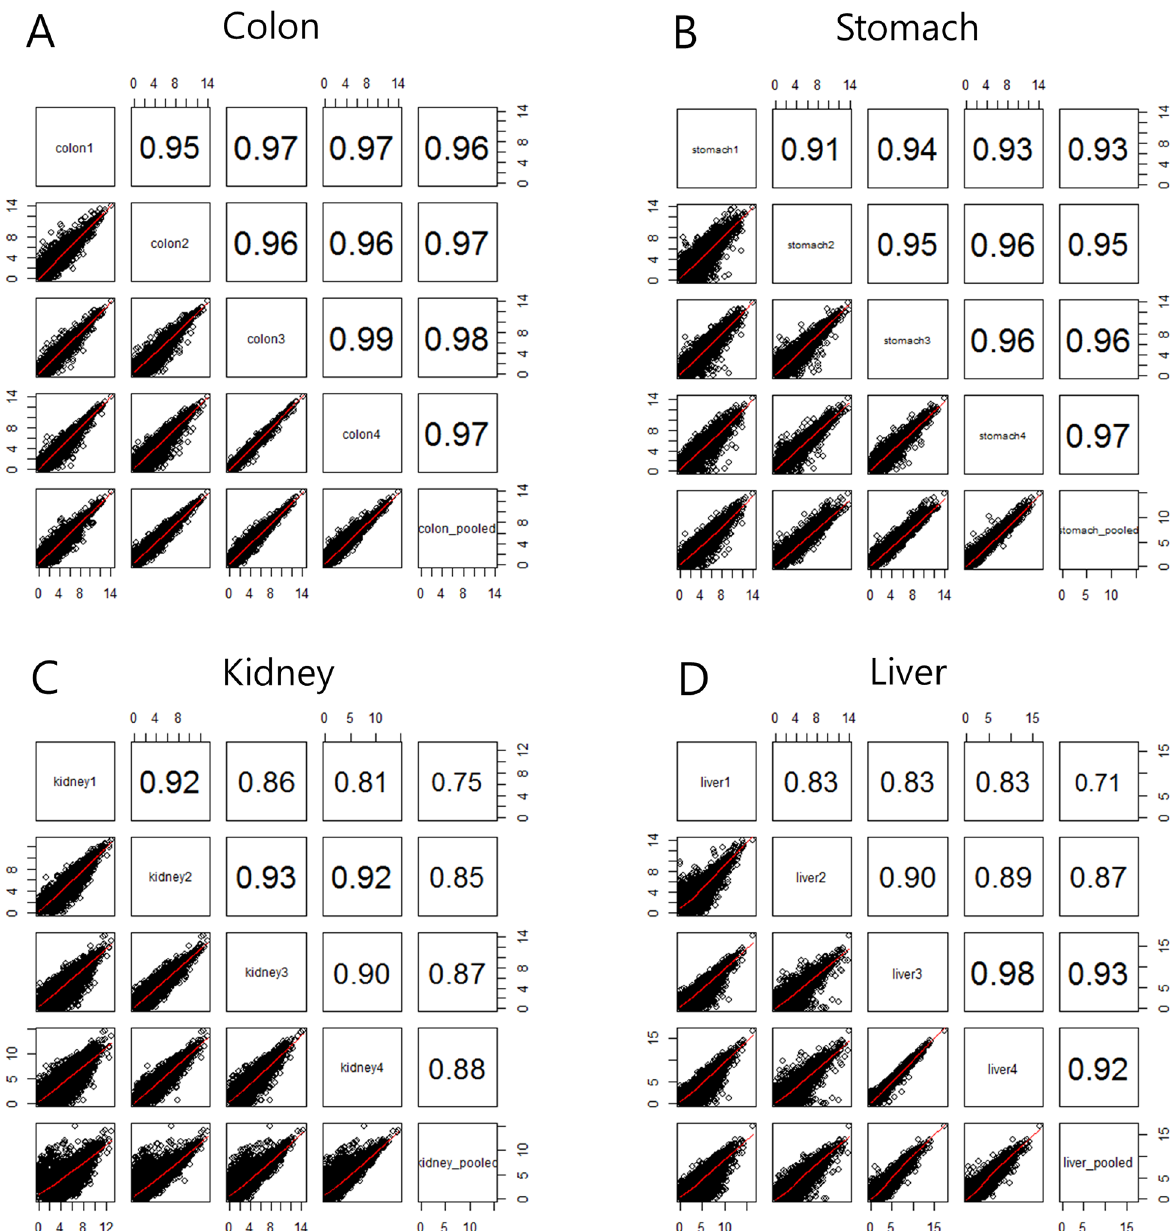
Fig 5. Pairwise correlations and scatter plots of expression profiles from whole transcriptome sequencing data. Pearson ’ s correlation coefficients included all coding